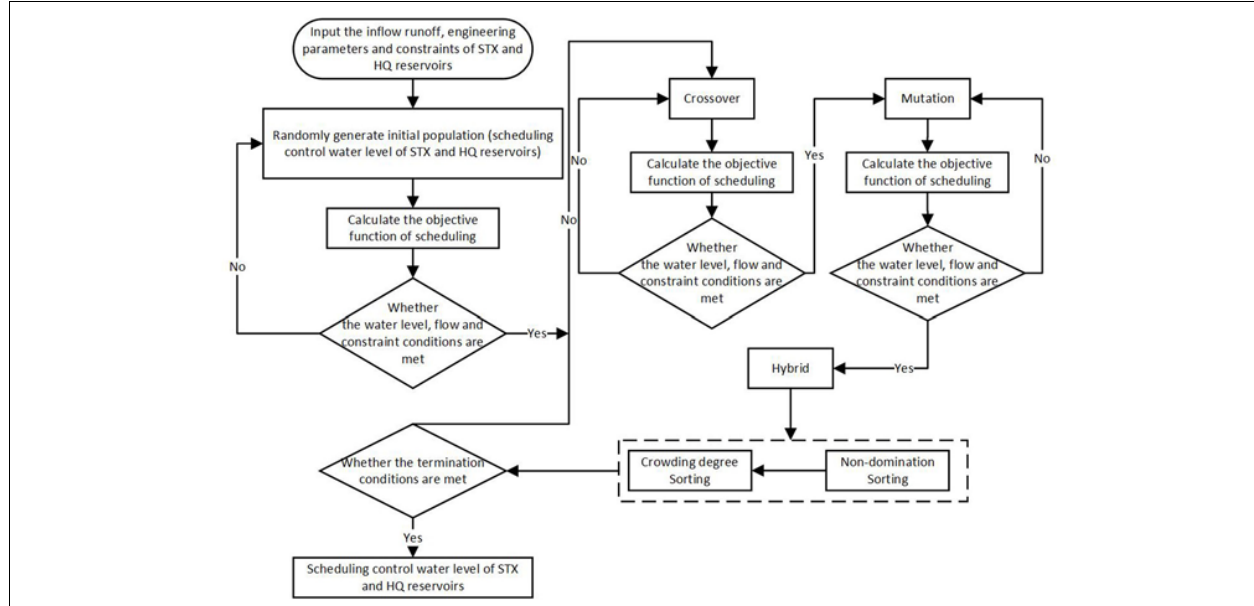
FIGURE 4 | The implementation processes.